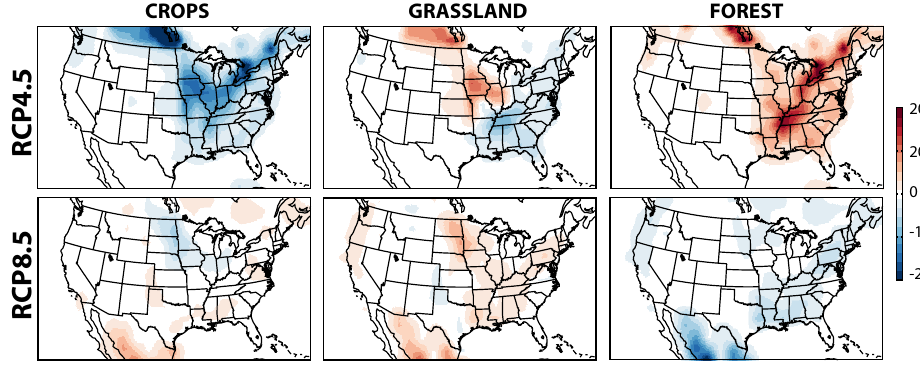
Figure 1. Projected 2050–2000 changes (%) in forests, grasslands and croplands by the RCP4.5 and RCP8.5 scenarios.